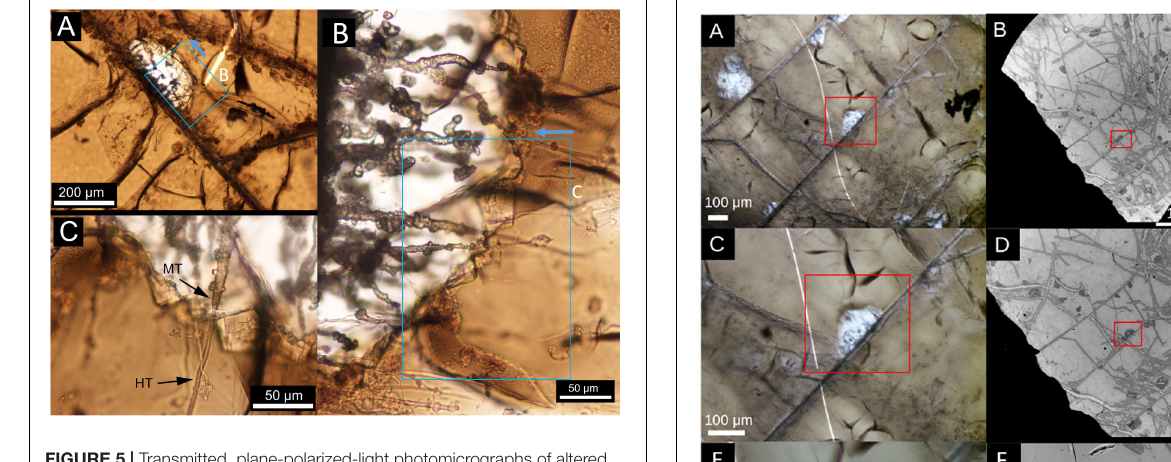
FIGURE 5 | Transmitted, plane-polarized-light photomicrographs of altered basaltic glasses hosting partially mineralized tubular alteration textures. (A) Large-scale view showing the formation of tubular textures rooted along fracture surfaces and extending into the basaltic glass, approximately perpendicular to the originating fracture surface. The panels (B,C) detail showing the transition from zeolite alteration zones (colorless) to fresh glass (brown). Note that tubular textures are continuous between the two zones; however, the parts of tubules lying within the zeolite alteration zones have been mineralized by titanite (MT), whereas the tubules are mostly hollow within unaltered glass (HT). Boxes with arrows denote the location and up direction of the succeeding image.